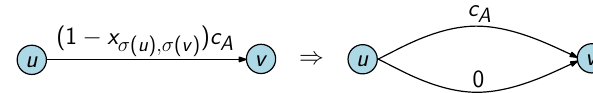
Figure 7 Replacing arcs with dynamic costs by two arcs with static